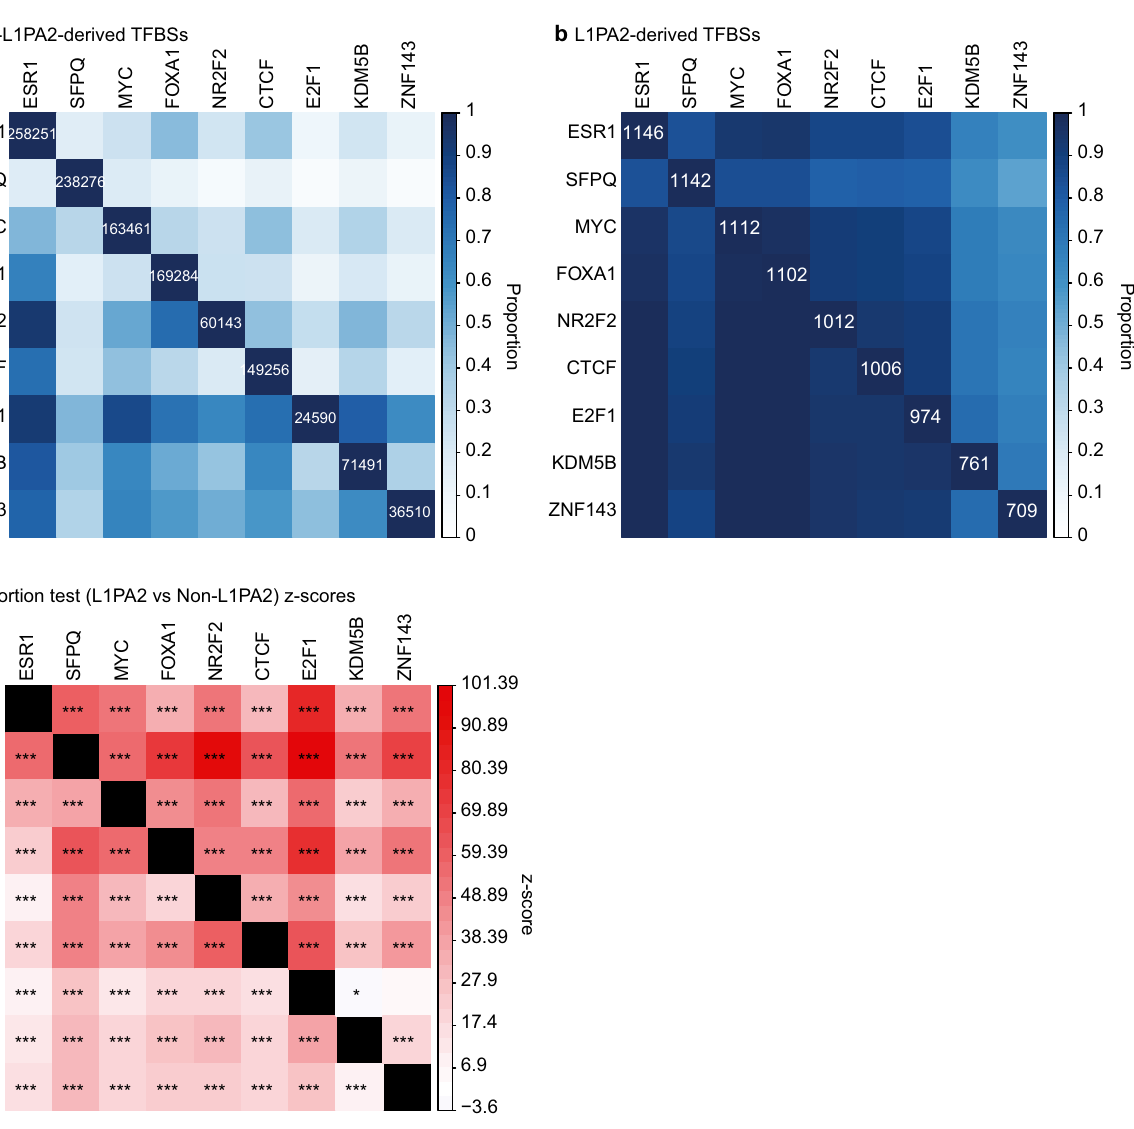
Figure 4. Top binding TFs co-occurred more frequently in L1PA2s than in the rest of the genome. The proportions of co-occurrence are shown for ( a ) non-L1PA2-derived and ( b ) L1PA2-derived TFBSs. For each TF, the total number of binding sites is shown in the diagonal. ( c ) For each TF-TF combination, the co-localisation proportions were compared (L1PA2 versus non-L1PA2) using a one-tailed proportion z-test. The heatmap indicates the z-scores of the proportion tests, where a positive z-score (red) indicates more co-localisation in L1PA2s, and a negative z-score (blue) indicates more co-localisation in the rest of the genome. P < 6.2E-4: *, p < 0.0001: **, p < 0.00001: ***. To account for asymmetrical co-localisation, the proportions and z-scores correspond to the chances of the TF in the row co-localising with the TF in the